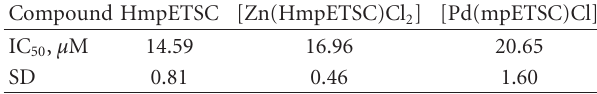
(V-N(1), 2.1333(14) ˚ A, V-N(7), 2.1651(13) ˚ A, and V-S(8), 2.3800(5) ˚A). The other two sites are occupied by oxo ligands